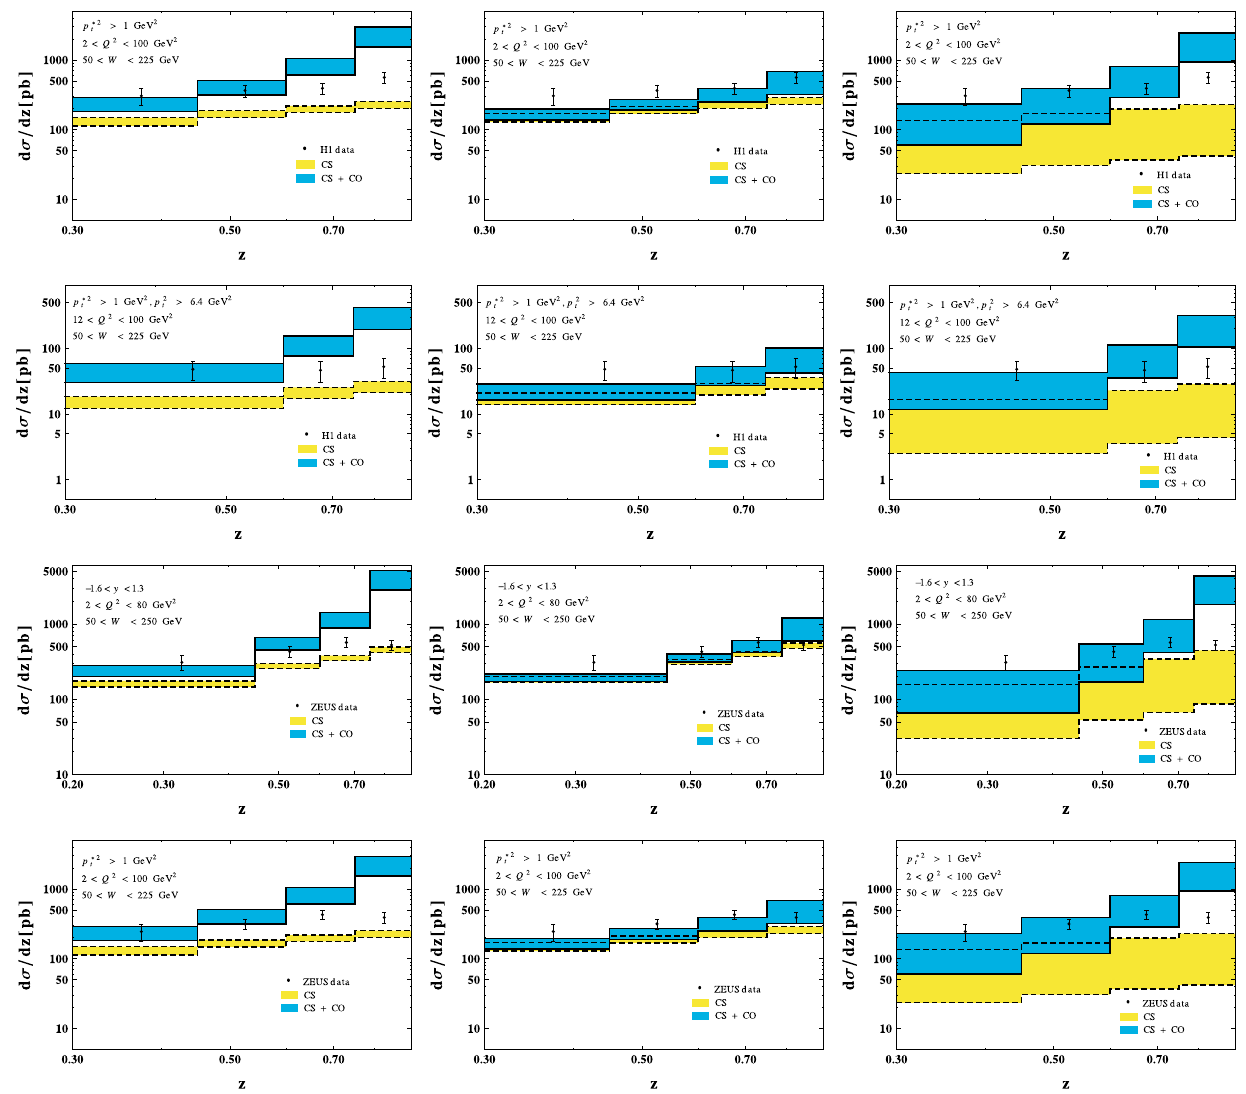
Fig. 15 The differential cross sections for the J /ψ production in DIS with respect to y (cid:11) ψ . The experimental data are taken from Ref. [49]. The l.h.s., middle, and r.h.s. plots correspond to the LDMEs taken in Refs. [28,30,41],